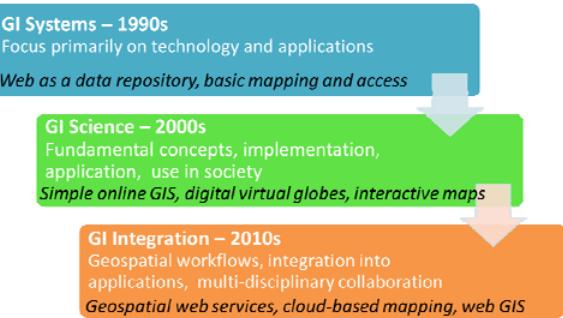
Figure 1: Three eras of development in GIScience education and web mapping (adapted from Veenendaal